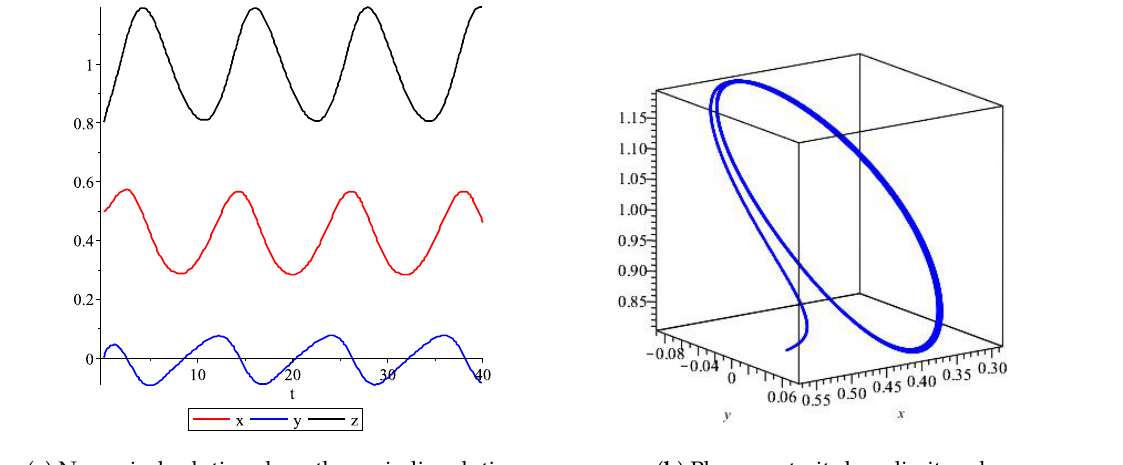
Figure 1. Solution for system Equation (6) when α = 0.9, β = 0.1827, σ = 0.736.